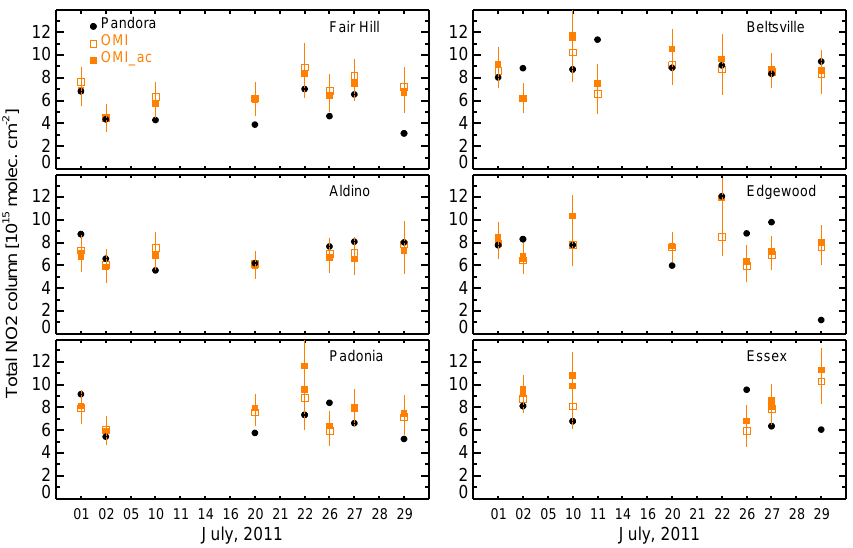
Figure 8. Comparison of total NO 2 columns retrieved from OMI (rectangles) with those retrieved from Pandora measurements (filled circles). Open squares represent the operational retrievals (using GMI profiles), and filled squares represent OMI retrievals performed using collocated aircraft-measured NO 2 vertical profiles. Error bars represent errors in Pandora and OMI retrievals.